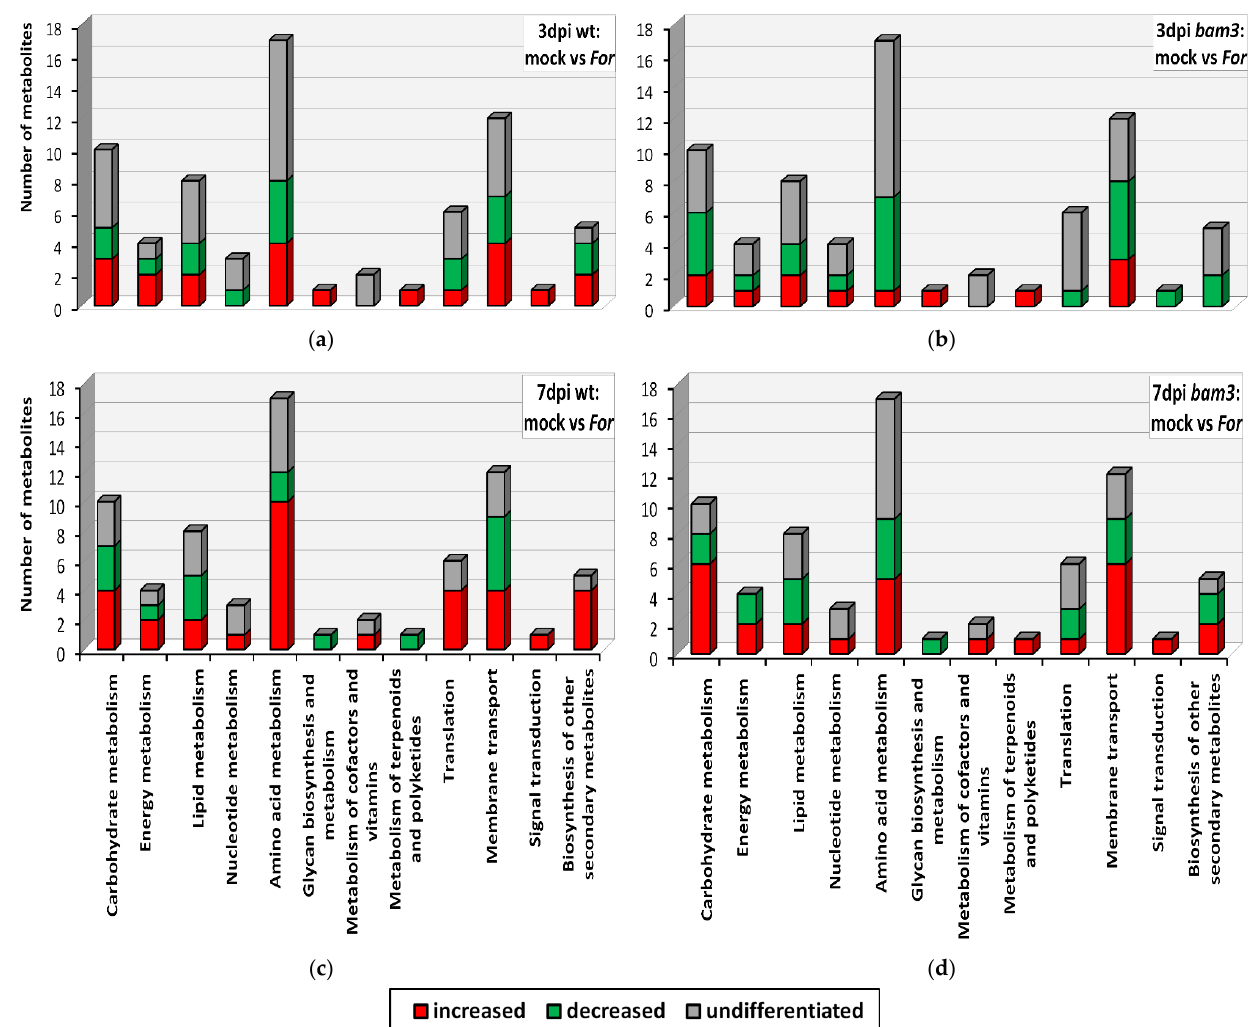
Figure 5. Classification of Arabidopsis thaliana wt and bam3 signatory metabolites based on their participation in metabolic pathways, according to the KEGG database, after inoculation with Fusarium oxysporum f. sp. raphani ( For ). The number of increased, decreased, and undifferentiated metabolites in the comparison between mock and For -inoculated wt plants at three and seven dpi are presented in graphs ( a ) and ( c ), respectively. The number of increased, decreased, and undifferentiated metabolites in the comparison between mock and For -inoculated bam3 plants at three and seven dpi are presented in graphs ( b ) and ( d ), respectively.